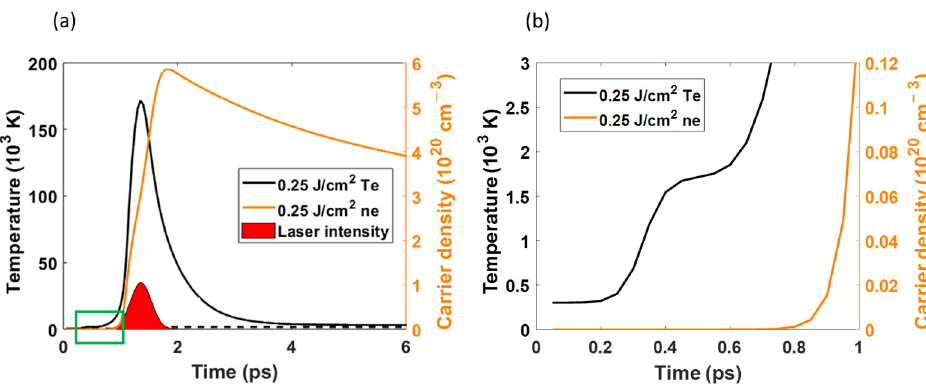
Figure 6. The temporal electron temperature and carrier density calculated by a 0.25 J/cm 2 fluence, ( b ) the magnification images of the green square of ( a ).